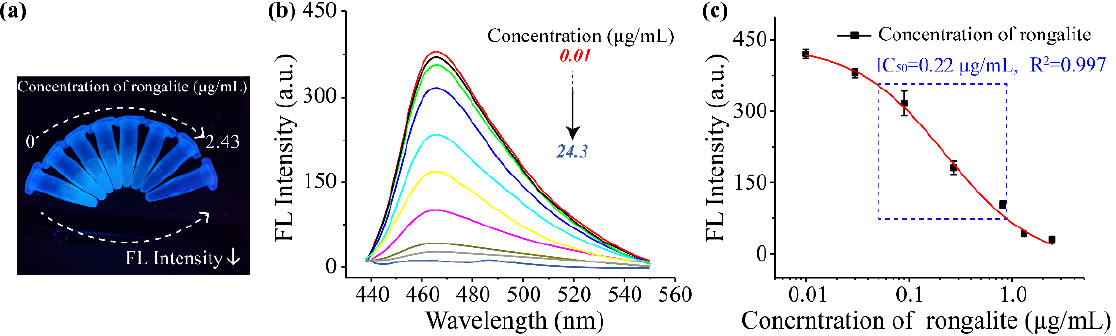
Figure 4. ( a ) Fluorescence photos and ( b ) fluorescence spectra of the fluorescence sensor exposed on a series of rongalite concentrations. ( c ) The standard curve of the quantification of rongalite.